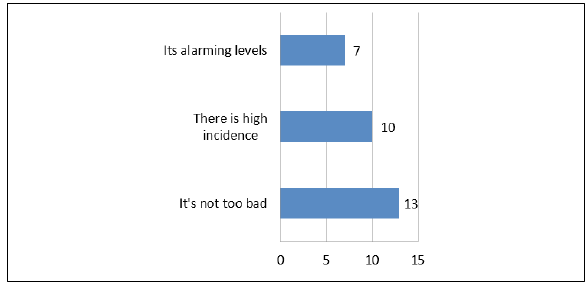
Figure 2: Respondents’ perceptions on the prevalence of sexually transmitted marks.